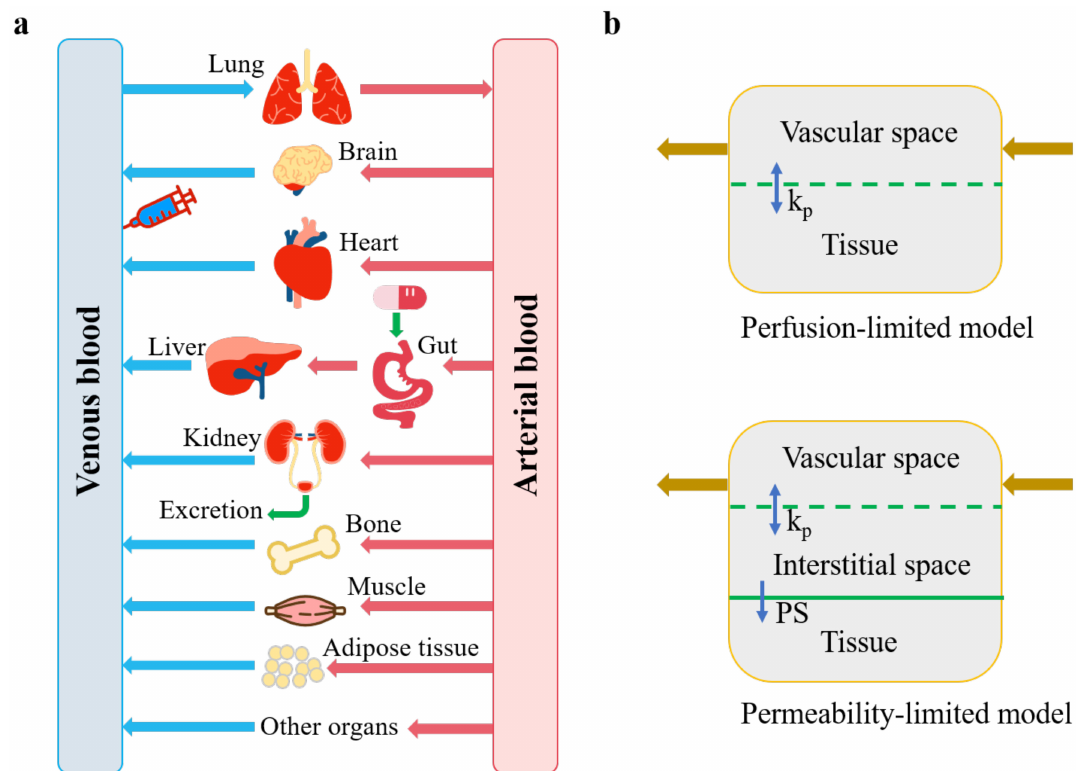
Figure 2. A generic physiologically based pharmacokinetic (PBPK) model ( a ) adapted from Shin, H.K. et al. [73], and 2 types of tissue model structure ( b ) adapted from Yuan, D. et al. [74]. k p , tissue partitioning coefficient, namely concentration ratio between tissue and blood at steady state; PS , membrane permeability